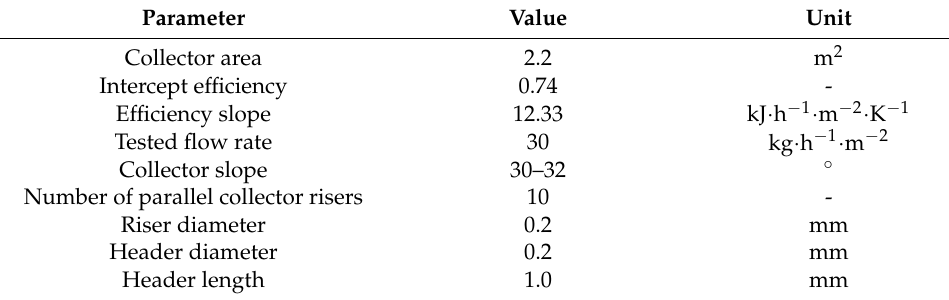
Table 2. Thermosyphon solar water heater characteristics.